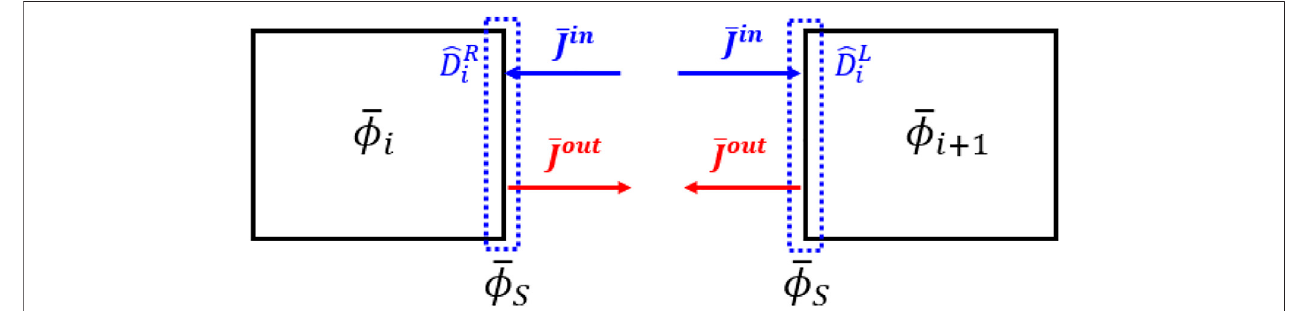
FIGURE 3 | Visualization of one-node CMFD correction factors.